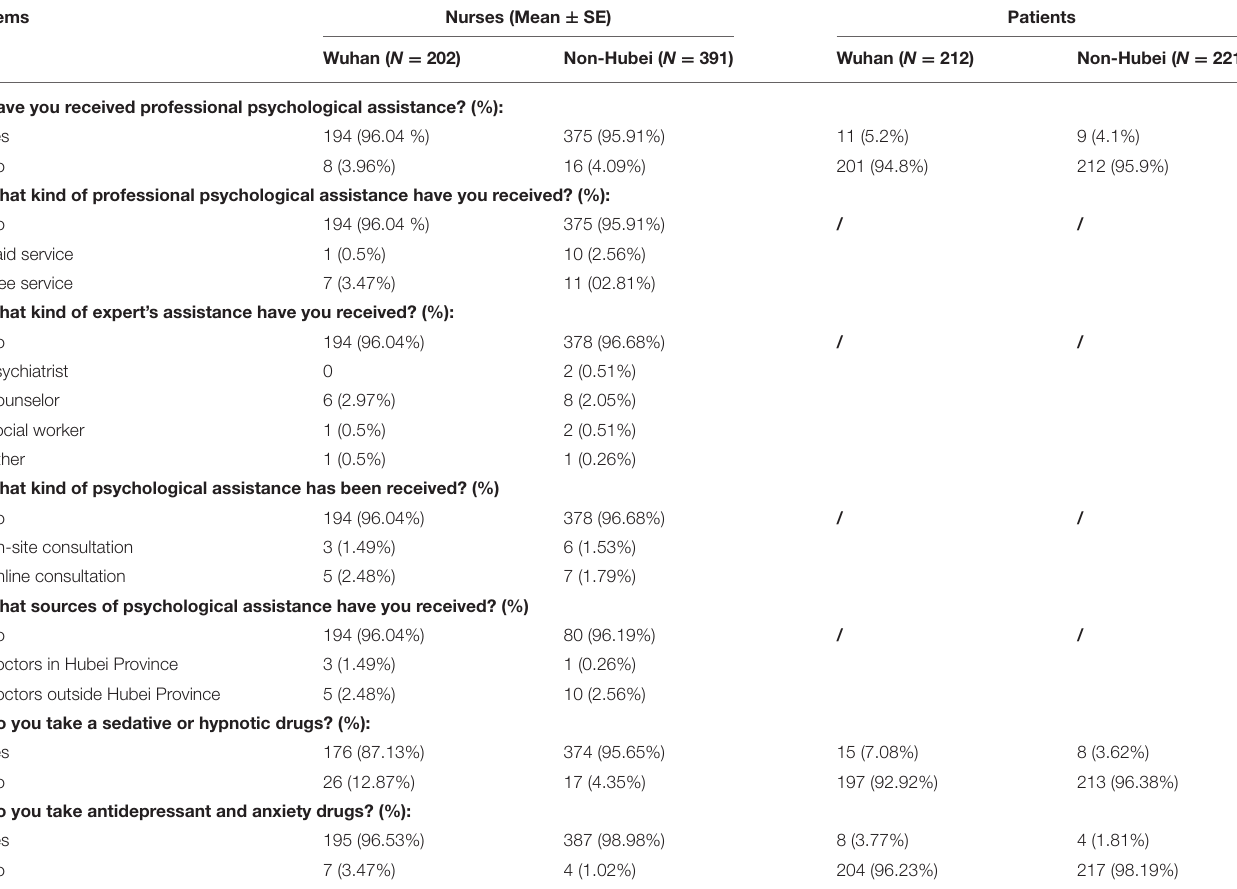
TABLE 6 | Mental health service for nurses and patients. Items Nurses (Mean ± SE)